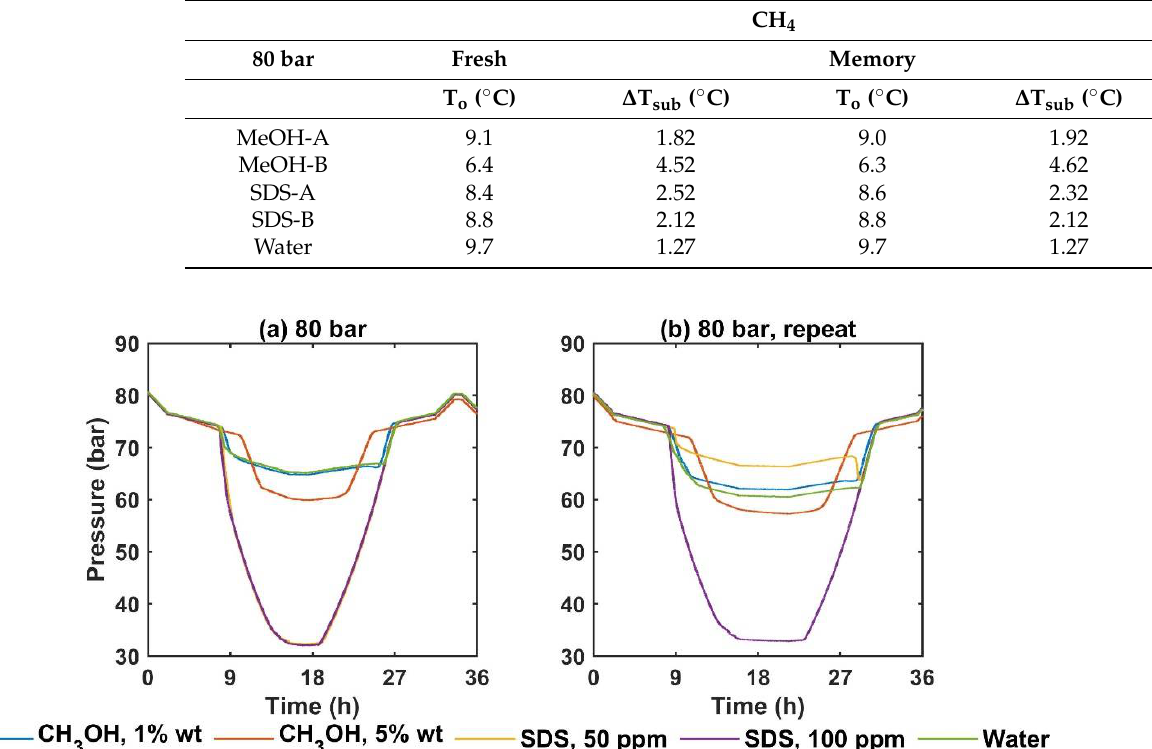
Figure 2. Pressure profiles during the constant ramping temperature scheme in the presence of MeOH (1% wt, 5 wt%) and SDS (50 ppm, 100 ppm). Starting pressure 80 bar and starting temperature 25 ◦ C, and final temperature 1 ◦ C. Temperature ramping rate 1 ◦ C/h between 15 ◦ C–1 ◦ C. ( a ) starting pressure 80 bar fresh run; ( b ) 80 bar fresh and